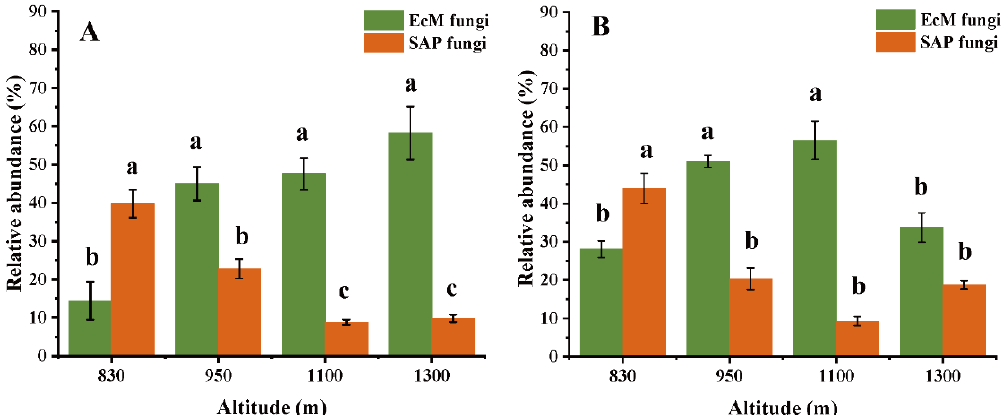
Figure 1. Relative abundances of the EcM and SAP fungal communities at different altitudes in the 0–10 cm (A) and 10–20 cm (B) soil layers. Different lowercase letters represent significant differences according to Tukey’s HSD test at different altitudes in the same fungal guilds ( p < 0.05).